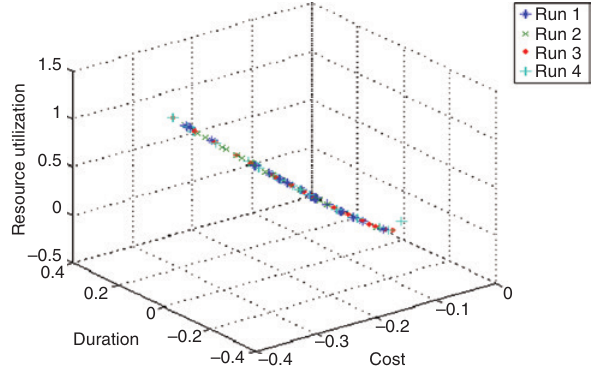
Figure 3: MOPSO Resource Optimization Pareto Front of All Runs.